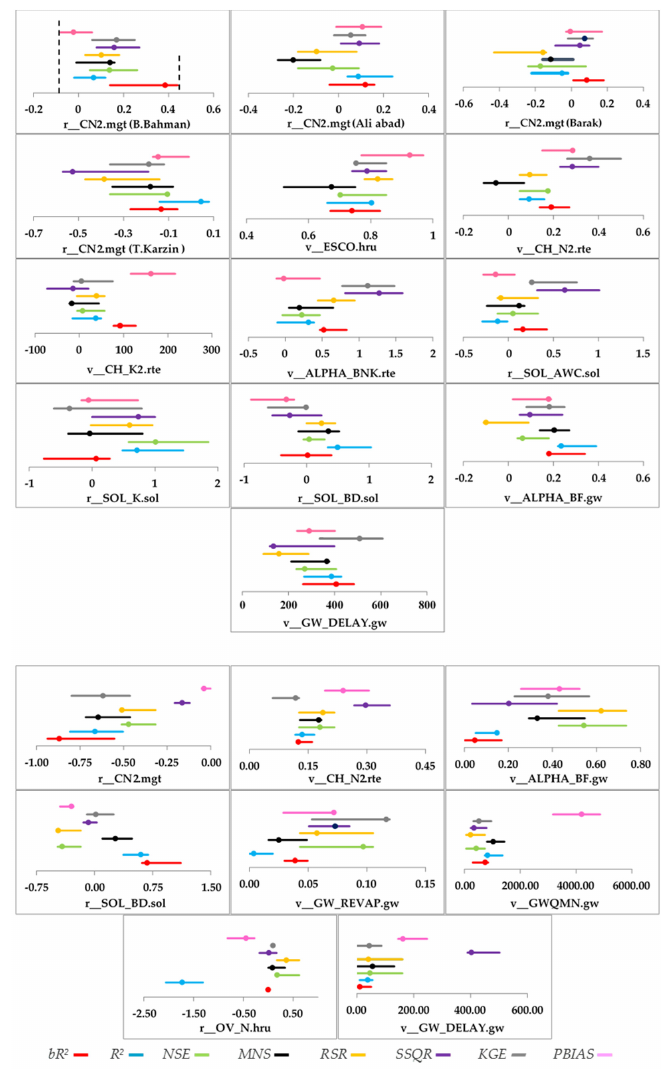
Figure 3. Uncertainty ranges of calibrated parameters using different objective functions in (Top) SDB and (bottom) KRB. The points in each line show the best value of parameters, r_ refers to a relative change where the current values are multiplied by (one plus a factor from the given parameter range), and v_ refers to the substitution by a value from the given parameter range [24]).